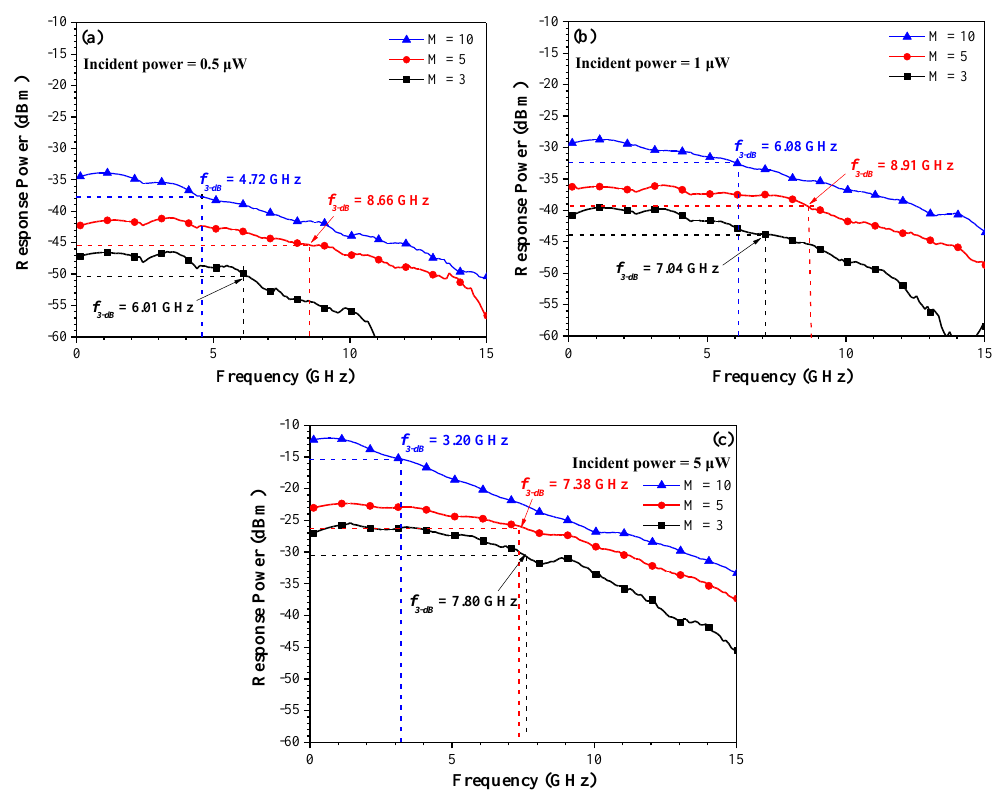
Figure 7. Measured f 3-dB values as a function of multiplication gain (3, 5, and 10) under incident optical powers of ( a ) 0.5 μ W, ( b ) 1.0 μW, and ( c ) 5.0 μW.